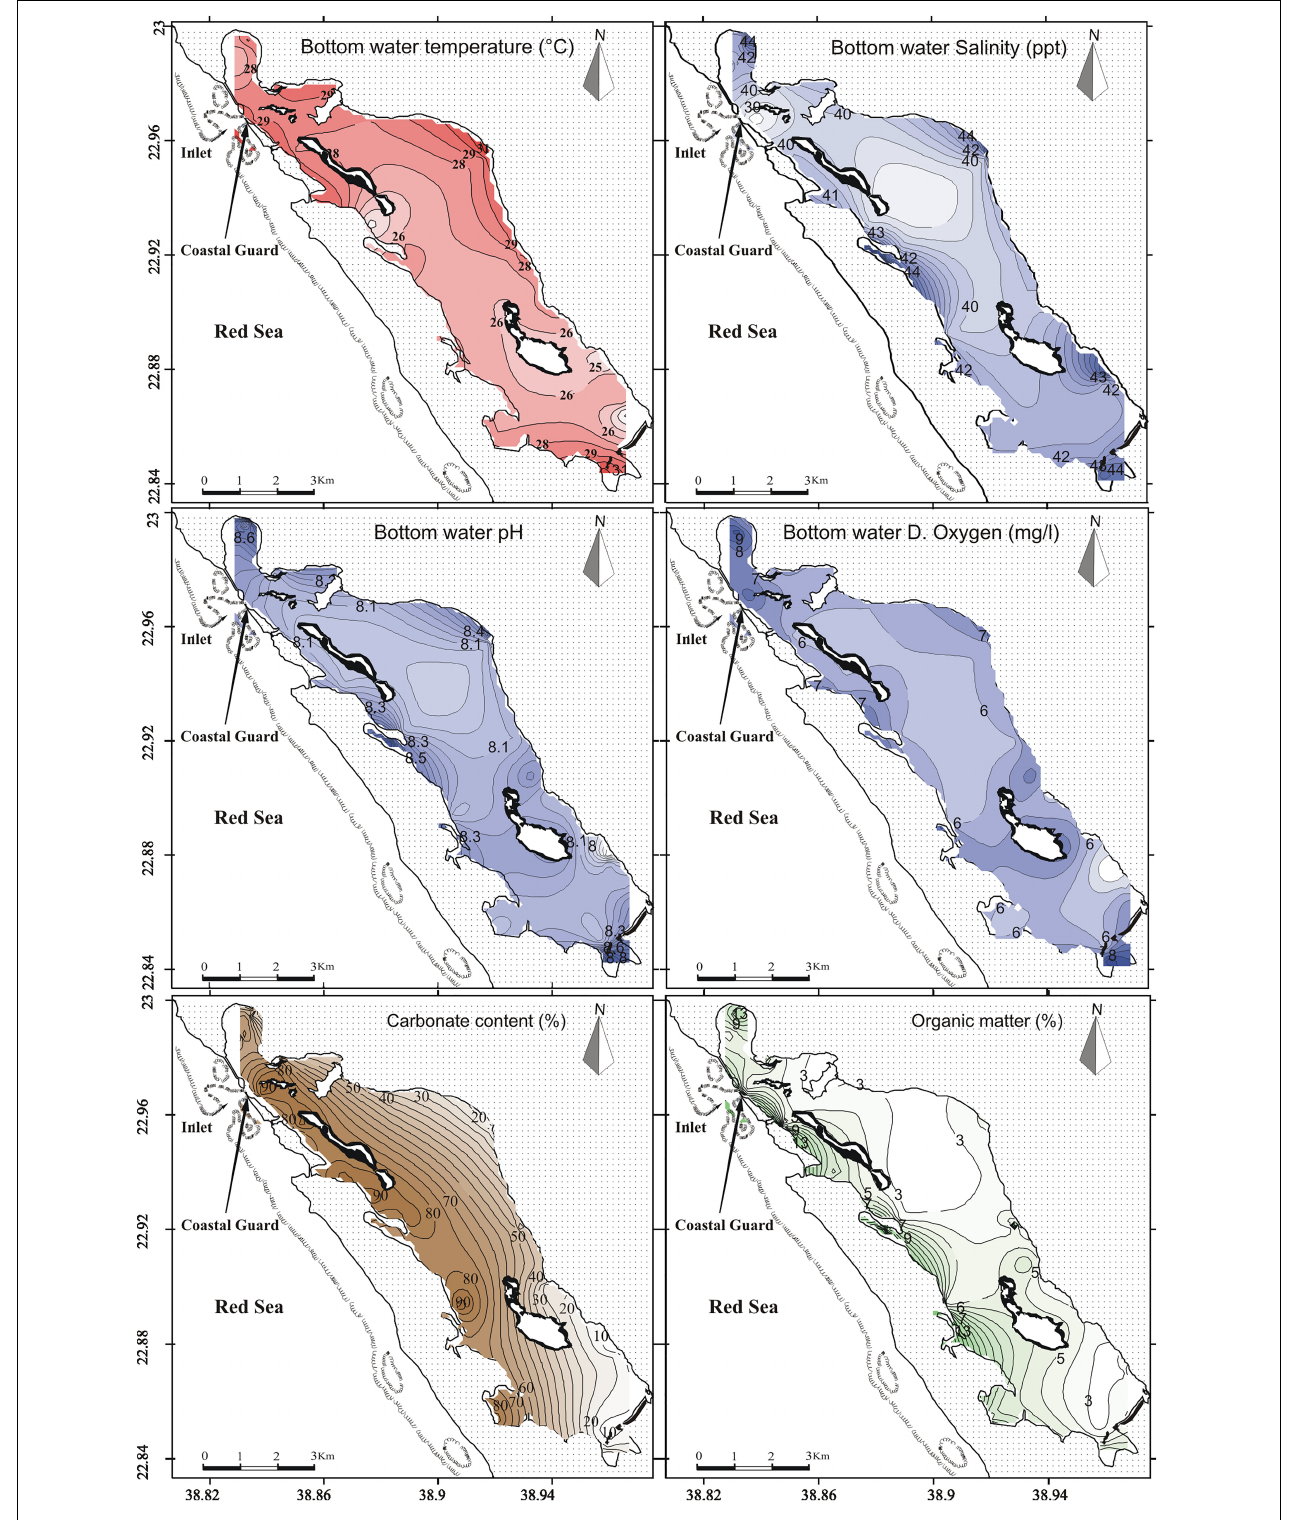
FIGURE 2 | Spatial distribution of physico-chemical parameters (bottom temperature, bottom salinity, bottom pH and bottom dissolved oxygen), carbonate and organic matter contents in the Al-Kharrar Lagoon during winter 2014.